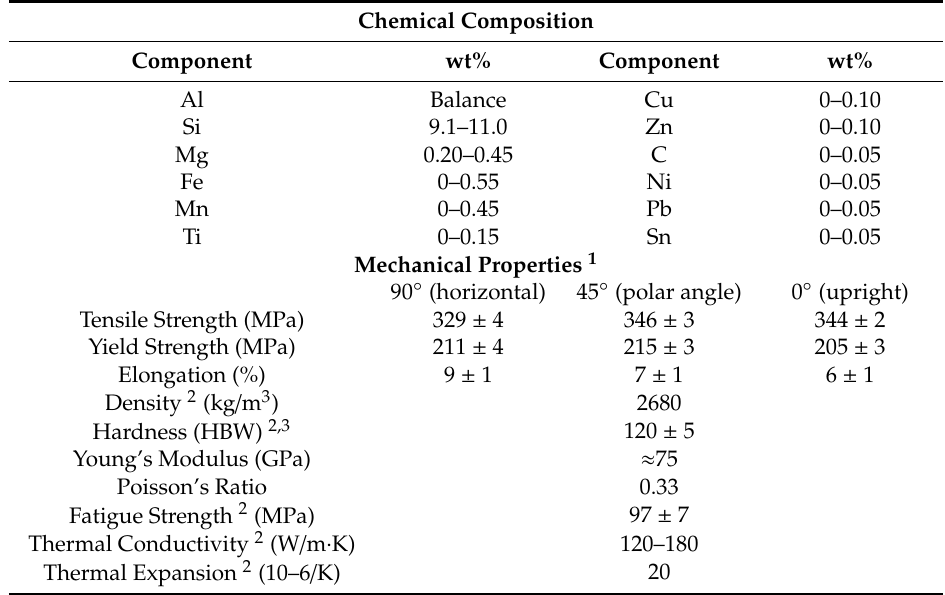
Table 1. AlSi10Mg chemical composition and mechanical properties (post heat treatment)